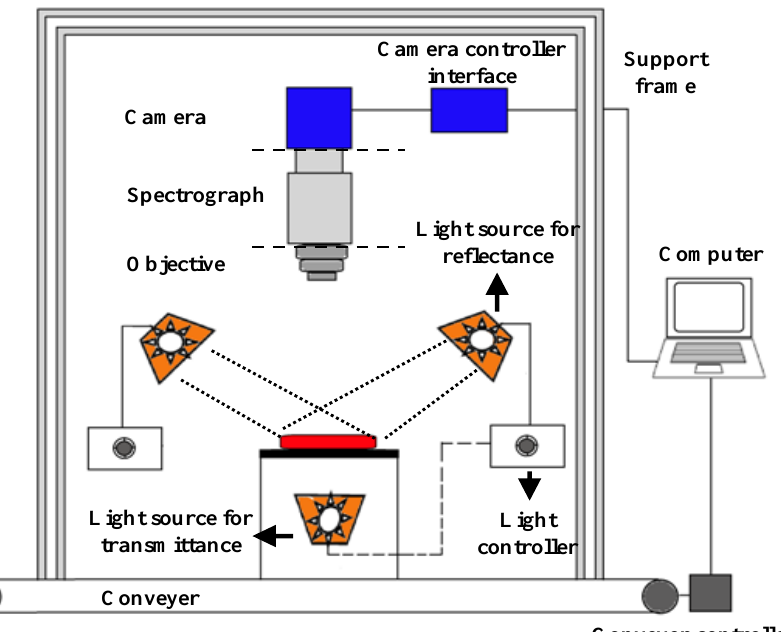
Figure 2. Configuration of a hyperspectral imaging